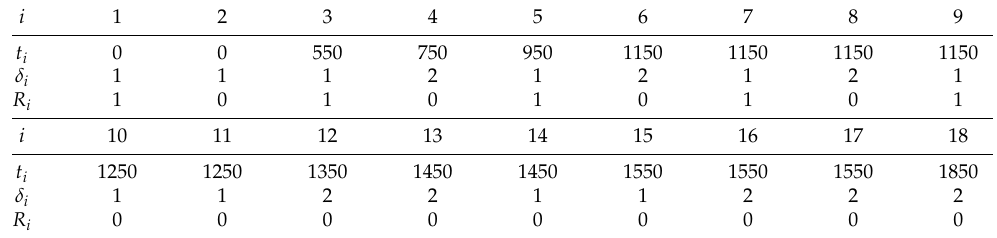
Table 5. Generated progressive Type-II competing risks sample from data of King [35].